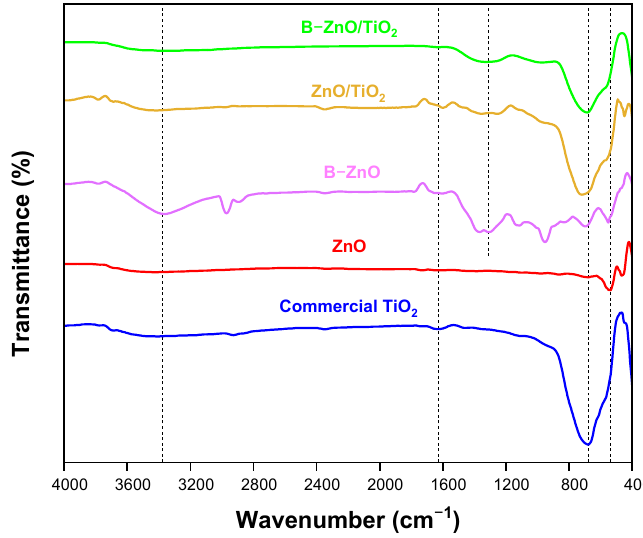
Figure 3. FTIR spectra of TiO 2 , ZnO, B − ZnO, ZnO/TiO 2 , and B − ZnO/TiO 2 .